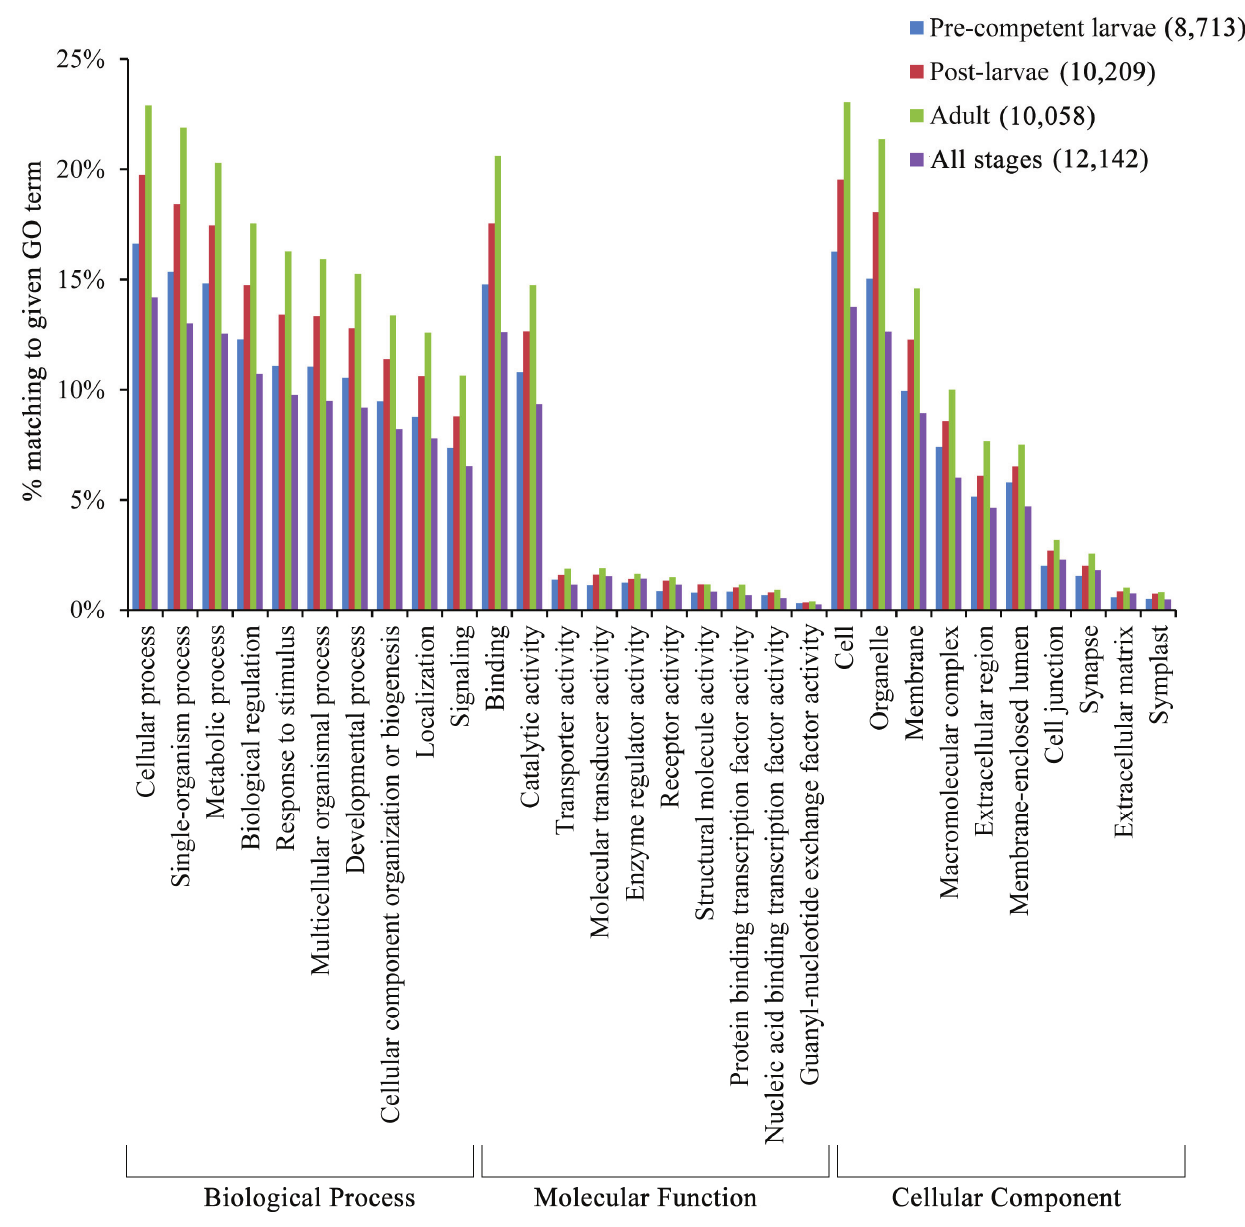
Figure 4. The distributions of Gene Ontology (GO) terms with the highest percentages of top BLAST hits. The percentages of total contigs with a significant BLAST hit to a given GO term are provided for the top ten classes of the four life cycle/all stages under the three highest categories of Biological Process, Molecular Function, and Cellular